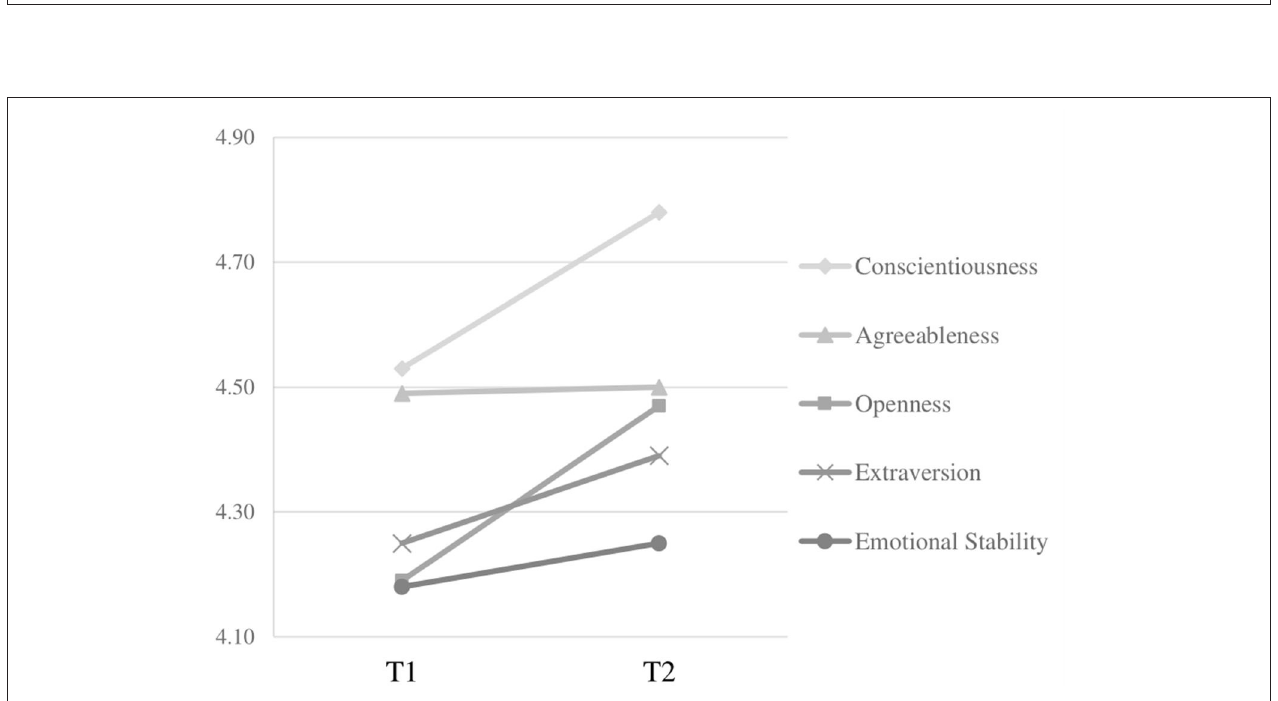
FIGURE 1 | Schematic model of the multiple-indicator univariate latent change score model. The latent construct of interest (each personality trait) was measured at two time points (T1 and T2), using three indicators each time (X1, X2, X3). The lower part of the model constitutes the assessment of measurement invariance. “ 1 latent change” captures change from the Big Five trait from T1 to T2. Latent regressions from “ 1 latent change” on Mod → 1 reflect the influence of the covariate perception of life event or the moderator mindset on the development of the Big Five. Straight arrows depict loadings and regression coefficients, curved arrows co-variances.